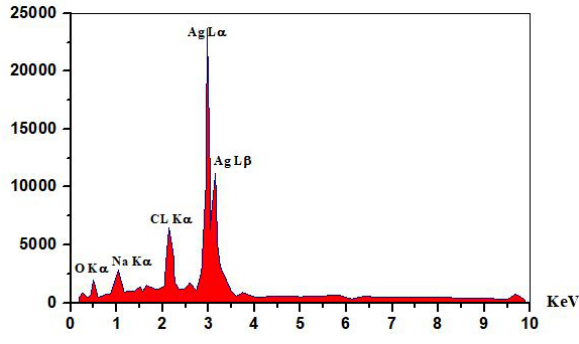
Figure 3: EDX elemental spectrum of Ag 2 O